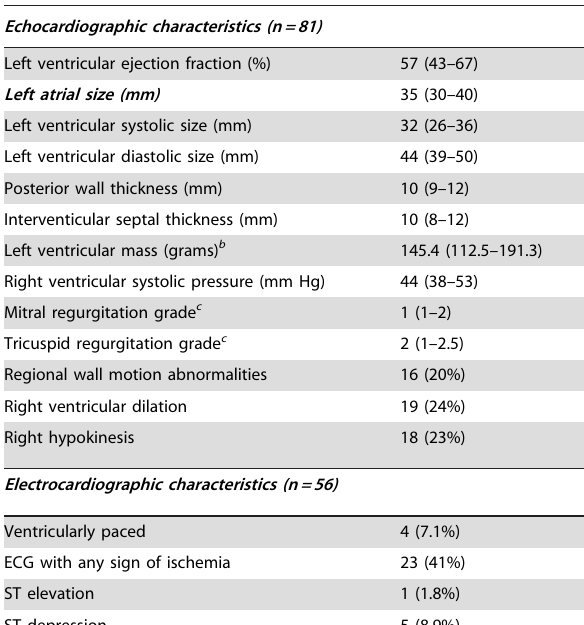
Table 4. Echocardiogram and electrocardiogram characteristics of study population. a